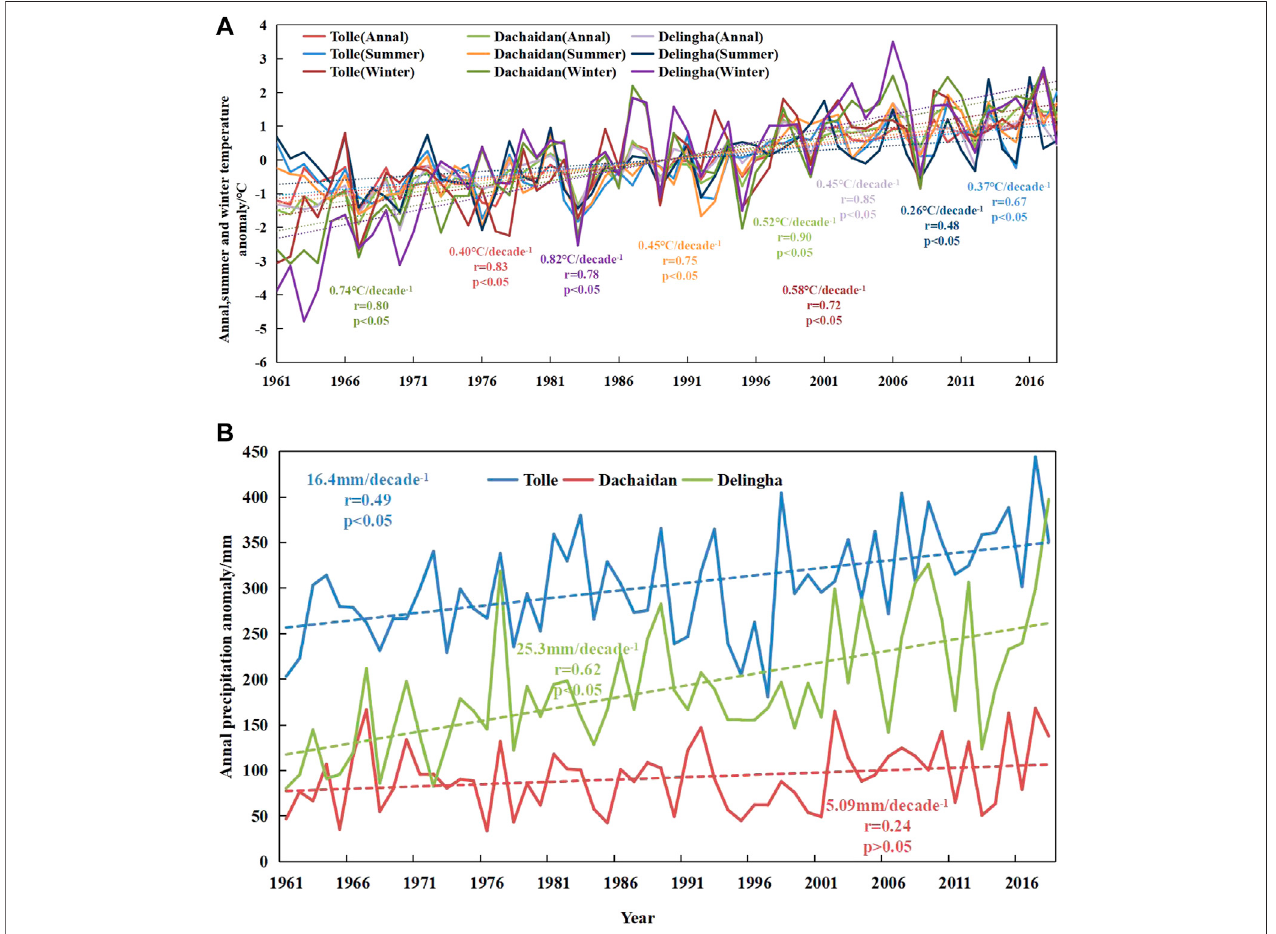
FIGURE 6 | Time series of (A) summer, winter and annual mean air temperature and (B) annual precipitation from the three meteorological stations nearest to the Turgen Daban Range from 1966 to 2020.